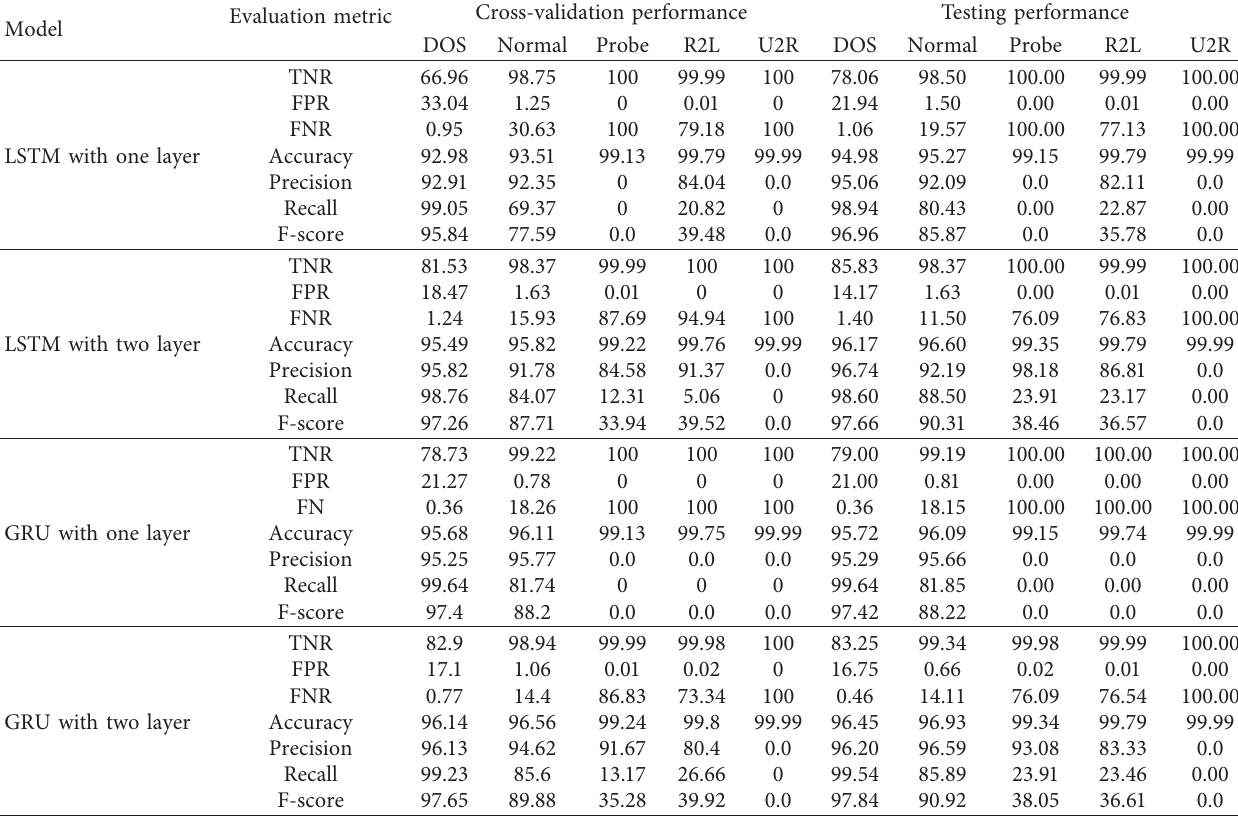
Table 17: The performance of deep learning for KDD dataset using LSTM and GRU with selected features. Evaluation metric Cross-validation performance Testing Model